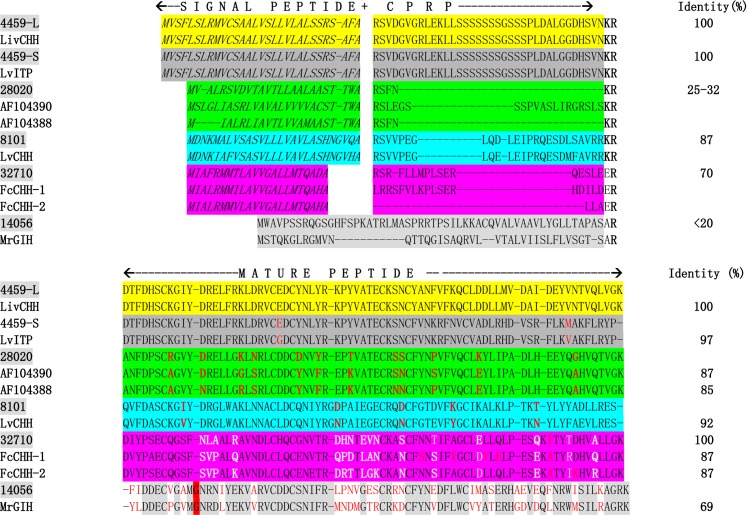
Alignment of the spermatophore CHHs with homologous sequence from different shrimps.The same horizontal colors indicate homologues that share a much higher degrees of amino acid identity in the mature peptide region. The predicted signal peptide of each member is in bold letters. The potential cleavage site is shown (in black bold letters) is the location to produce the mature peptide (i.e. KR and ER). No signal peptide was predicted for translate product of transcript 14056 and MrGIH and the glycine at position 11 is highlight in red. The identity (%) on the left of the table indicated the overall amino acid identity of the mature peptides between members of the same color horizontal block. Un-identical amino acid of the aligned sequence within the same horizontal color blocks are indicated by the bolded white or red letters.